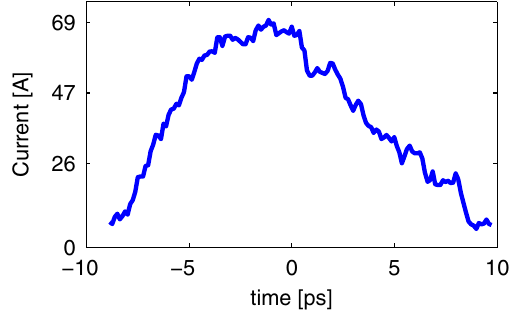
FIG. 4. Streak camera data with the effect of the R 56 shear removed to provide the longitudinal phase space at the dipole entrance.